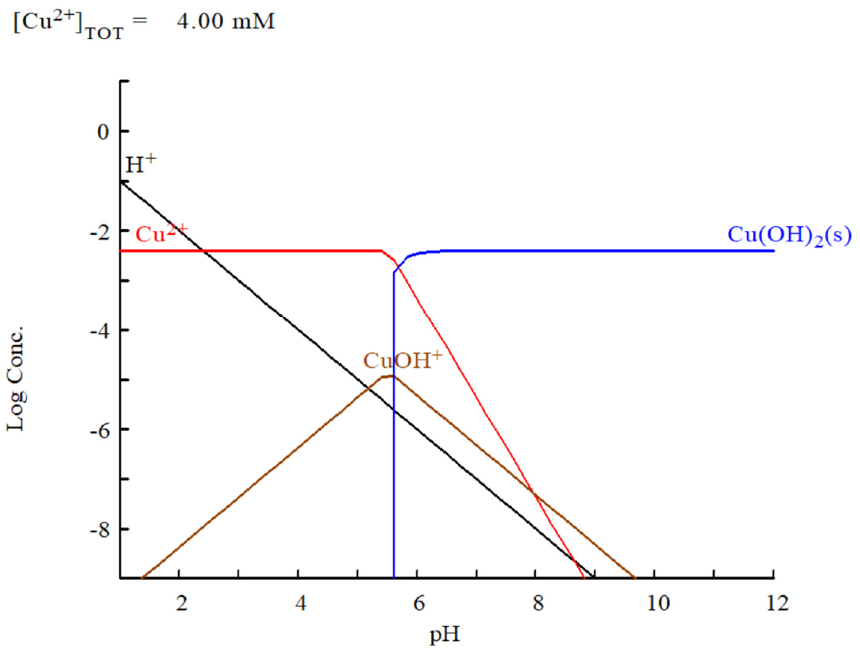
Figure 9. Morphological curve of 4 mM copper ions at different pH values.